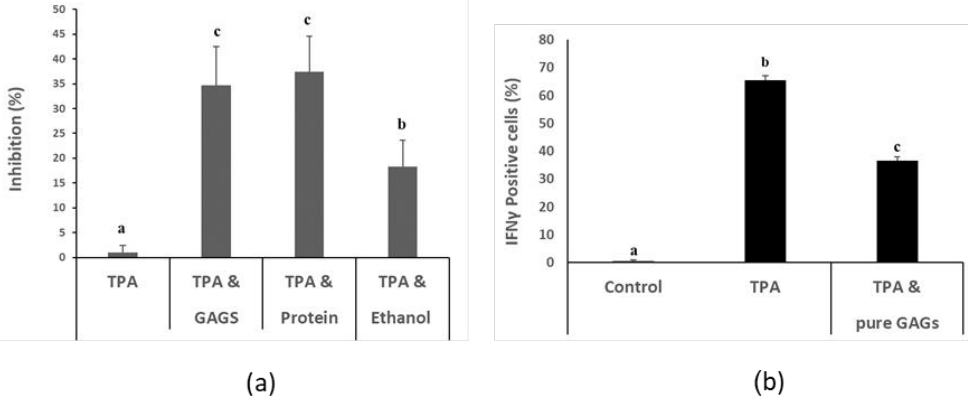
Figure 1. Extracts (crude GAGs, soluble proteins, ethanol soluble) from the body wall of I. badionotus inhibit 12-O-tetradecanoylphorbol-13-acetate (TPA)-induced proliferation of HaCat [human keratinocyte] cells in culture ( a ). Purified GAGs (3 μg/m L) limit TPA-mediated production of Interferon gamma (IFNγ) -positive HaCaT cells ( b ). N ≥ 4 per group and values with distinct superscripts differ significantly from each other ( p ≤